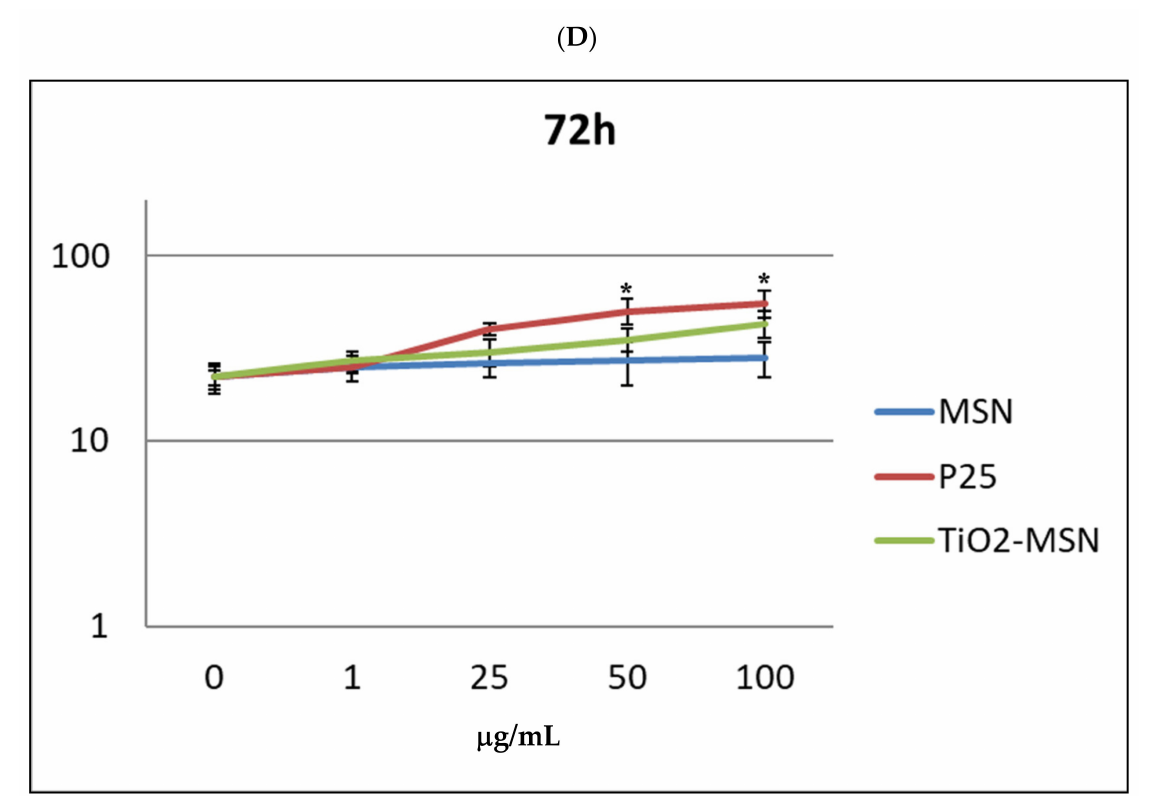
Figure 6. Reactive oxygen species (ROS) detection by DCFDH probe at increasing time of exposure: ( A ) 6 h. ( B ) 24 h. ( C ) 48 h. ( D ) 72 h. Significance values: * or #: p < 0.05; ** or ##: p < 0.005; ***: p < 0.0005; error bars represent the standard error of the